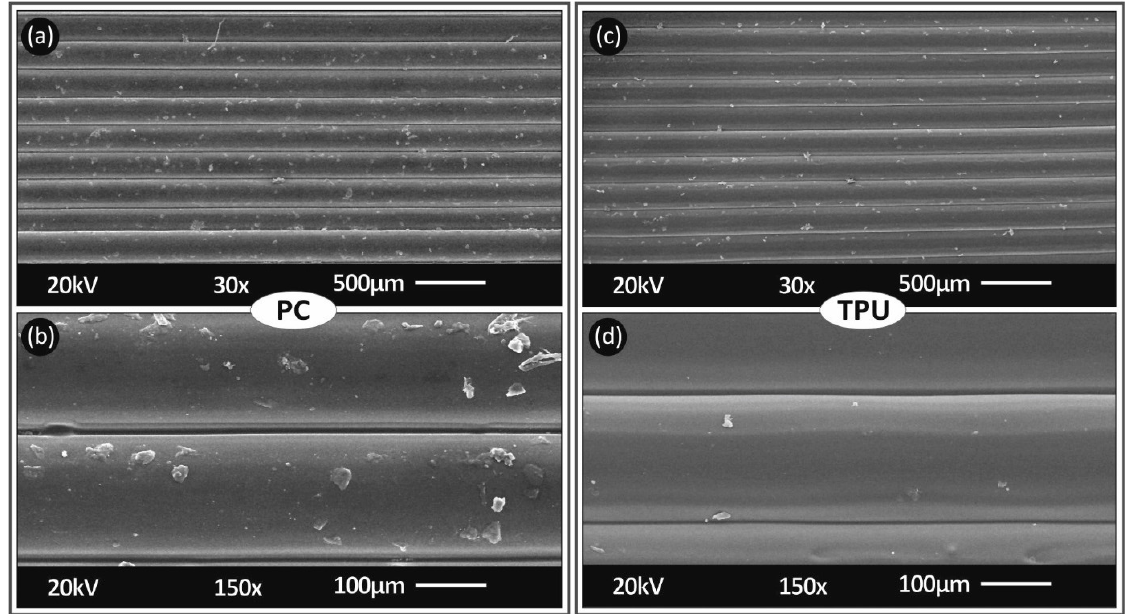
Figure 11. Side surface SEM captures of 3D printed specimens for PC (built at a 260 °C nozzle temperature, with a 0.2 mm layer thickness) ( a , b ) and TPU (built at a 215 °C nozzle temperature, with a 0.2 mm layer thickness) ( c , d ) materials at 30x ( a , c ) and 150 × magnifications ( b , d ).